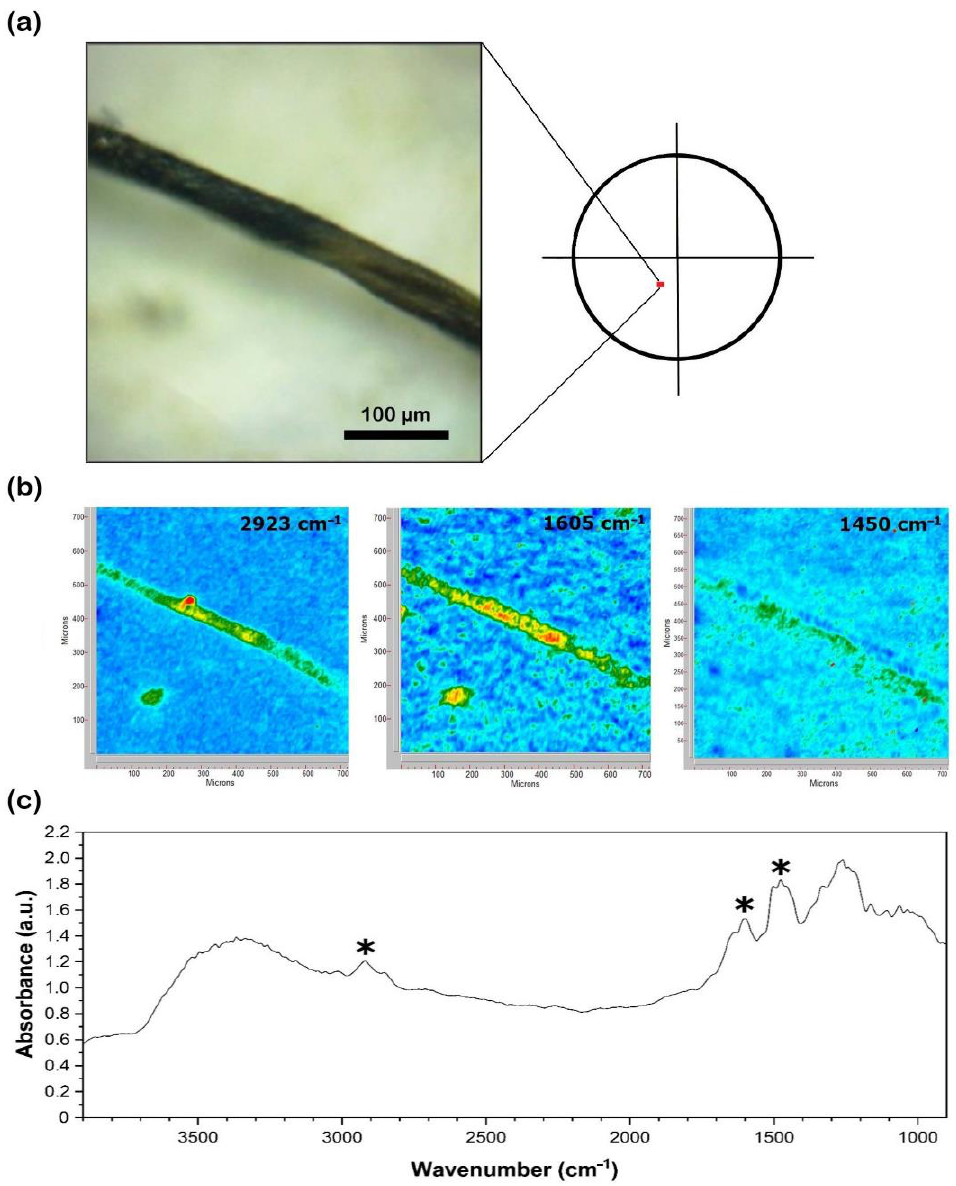
Figure 3. ( a ) Visible light map of the filter substrate with an SBR microfiber lying on it; ( b ) 2D FTIR imaging maps where the intensity of the following bands was mapped: 3000–2900 (aromatic and aliphatic CH stretch), 1605 (aromatic ring stretch), and 1450 cm − 1 (CH 2 bend). The chromatic scale of each map qualitatively shows the absorbance intensity as follows: blue, green, yellow, red; ( c ) FTIR reflectance spectra of the SBR microfiber and diagnostic bands ( * symbol), assigned according to reference standards reported in